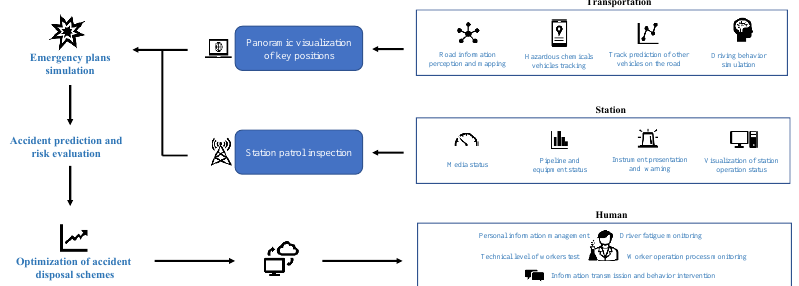
Figure 3. Basic functions of the system.